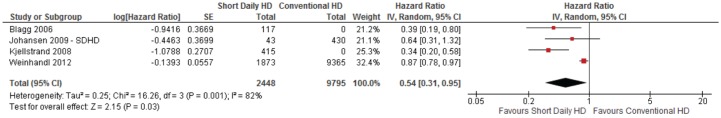
Comparative risk of mortality in short daily home HD versus conventional HD.